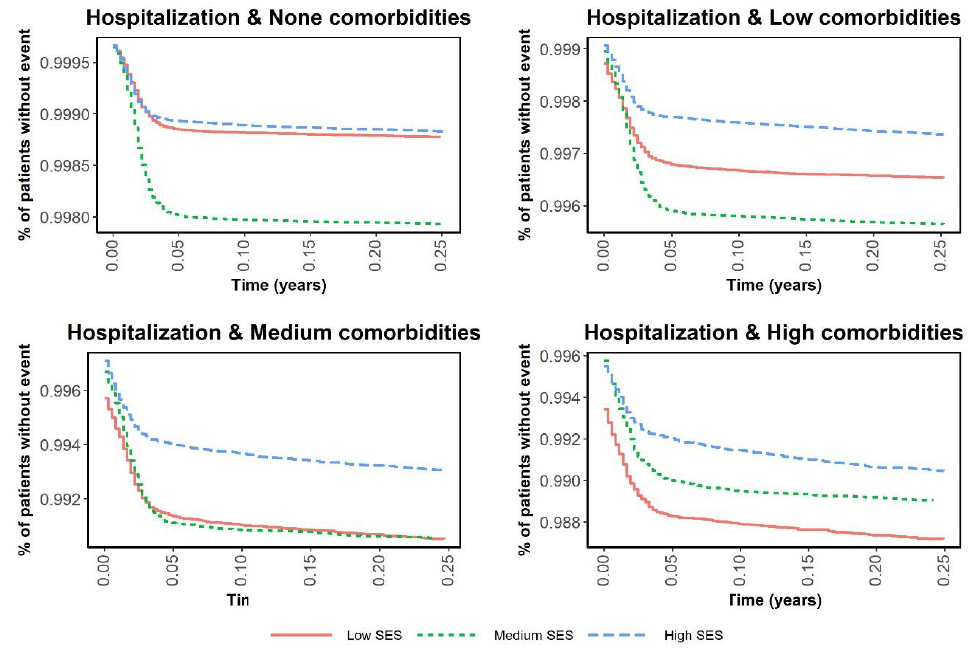
Figure 3. Kaplan–Meier curves of time to infection by Charlson Comorbidity Index and period. Figure 3. Kaplan – Meier curves of time to infection by Charlson Comorbidity Index and period.